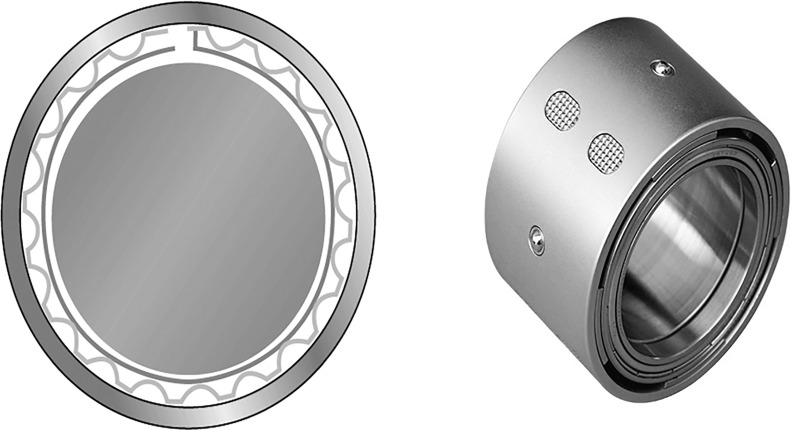
Schematic diagram of elastic foil gas bearing and its entity.